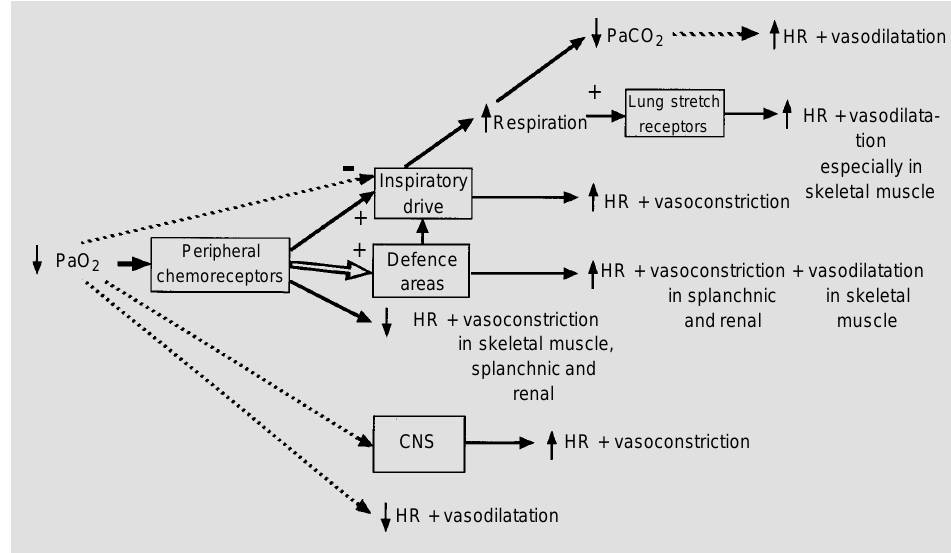
Figure 2 - Schematic diagram showing the possible effects of systemic hypoxia. + indicates an excitatory effect; - indicates an hibitory effect. Arrows as in Fig- ure 1. CNS, Central nervous sys- tem; HR, heart